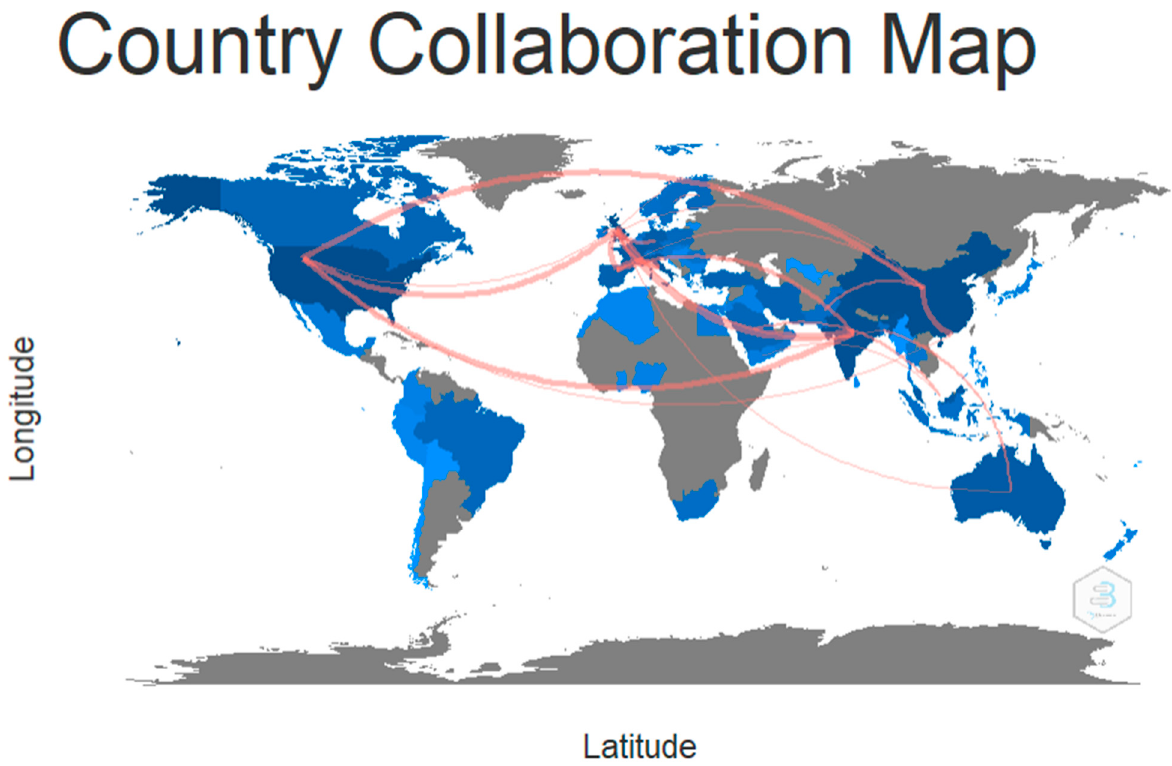
Figure 7. Country collaboration map.